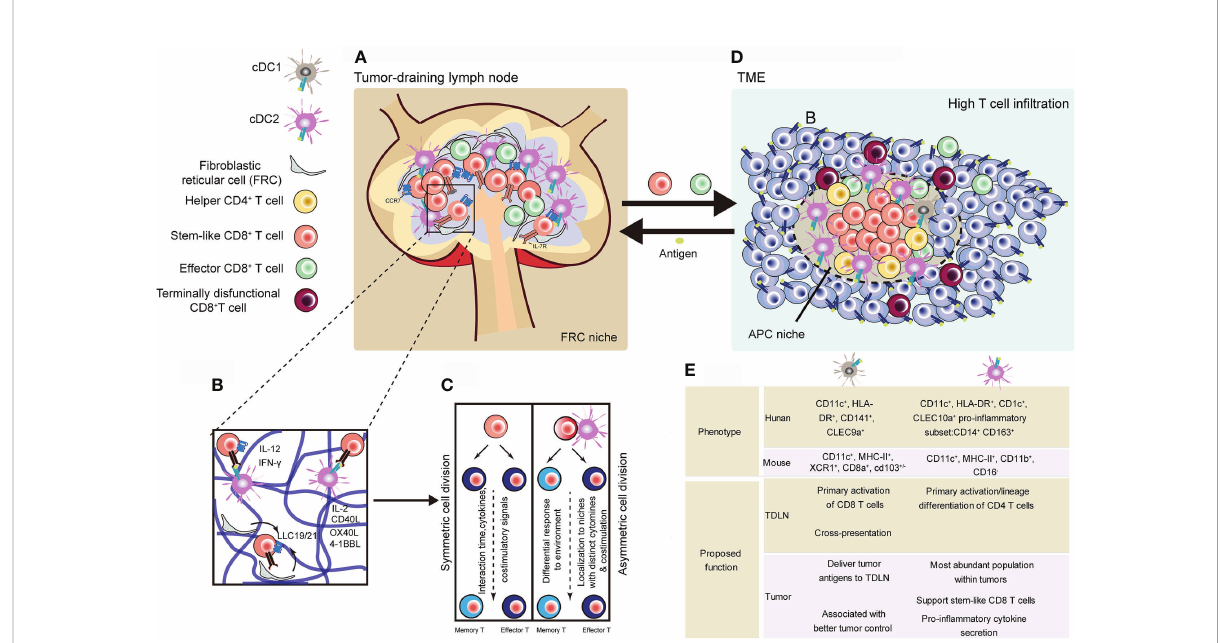
FIGURE 3 Representative niches supporting the maintenance of stem-like CD8 + T cells. (A) Stem-like CD8 + T cells in lymphoid niches differentiate into cytotoxic effector T cells, regulating tumor regression (44). (B) CCR7 + naïve CD8 + T cells localize and in the inner cortex (blue) and depend on homeostatic factors from niche supported by fi broblastic reticular cell. Activation process of CD8 + T cells can be divided into three phases, during which regulation signals are unleashed from surrounding, especially DCs (123 – 125). (C) After activation signals, T cells undergo symmetric or asymmetric cell division. Daughter cells transform into TEFF or memory T cells depending on their distance to DCs (32, 126). (D) Tumors with high dense of TILs show APC-niches, containing cDC1, cDC2 and helper CD4 T cells and stem-like CD8 T cells (50, 127 – 130). (E) Comparisons of human and mouse cDCs found in TDLNs and tumors (43, 49, 50, 127, 131 – 134). cDC, conventinal dendritic cell; TDLN, tumor- draining lymph node (129, 130, 135 –